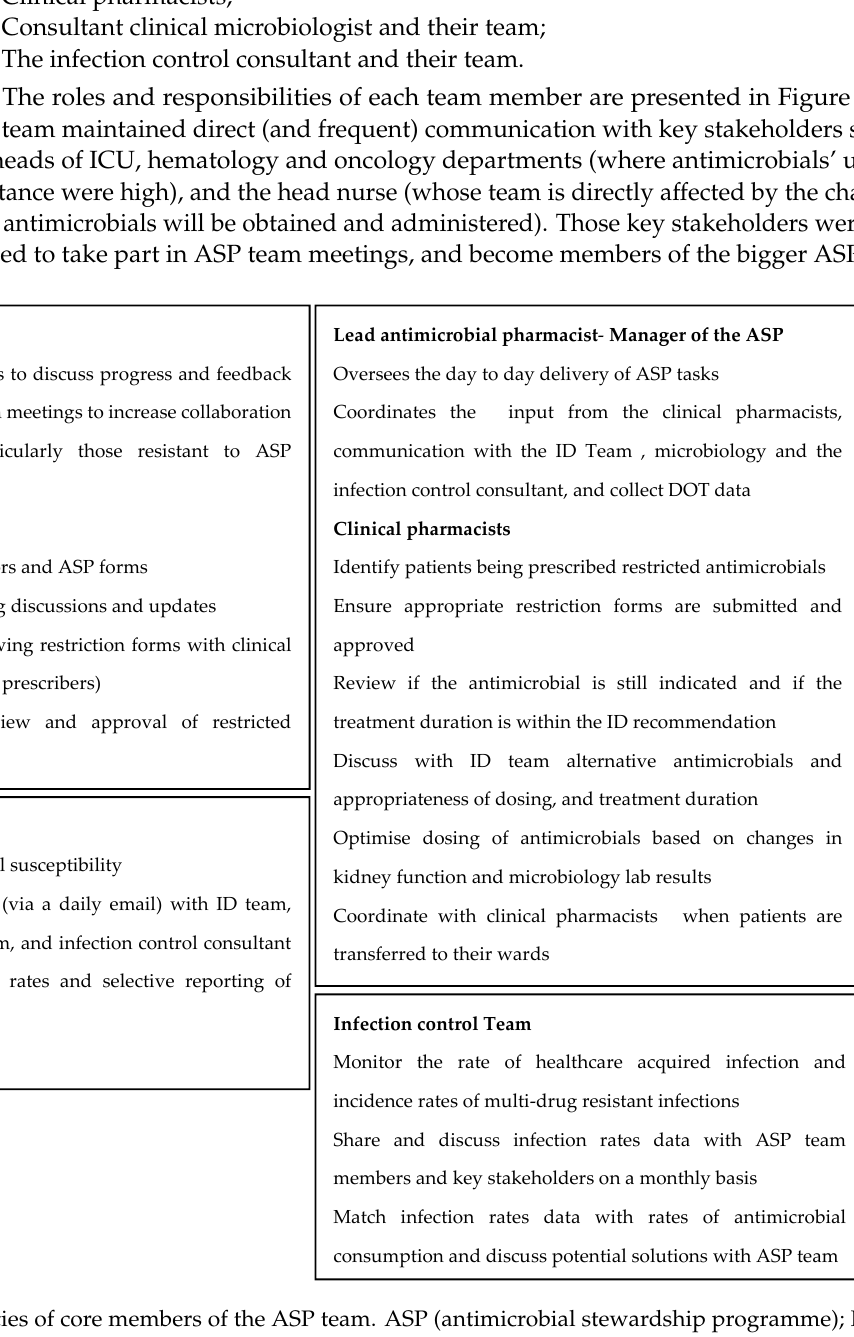
Figure 2. Roles and responsibilities of core members of the ASP team. ASP (antimicrobial stewardship programme); ID (Infectious Diseases); DOT (Days of Therapy).